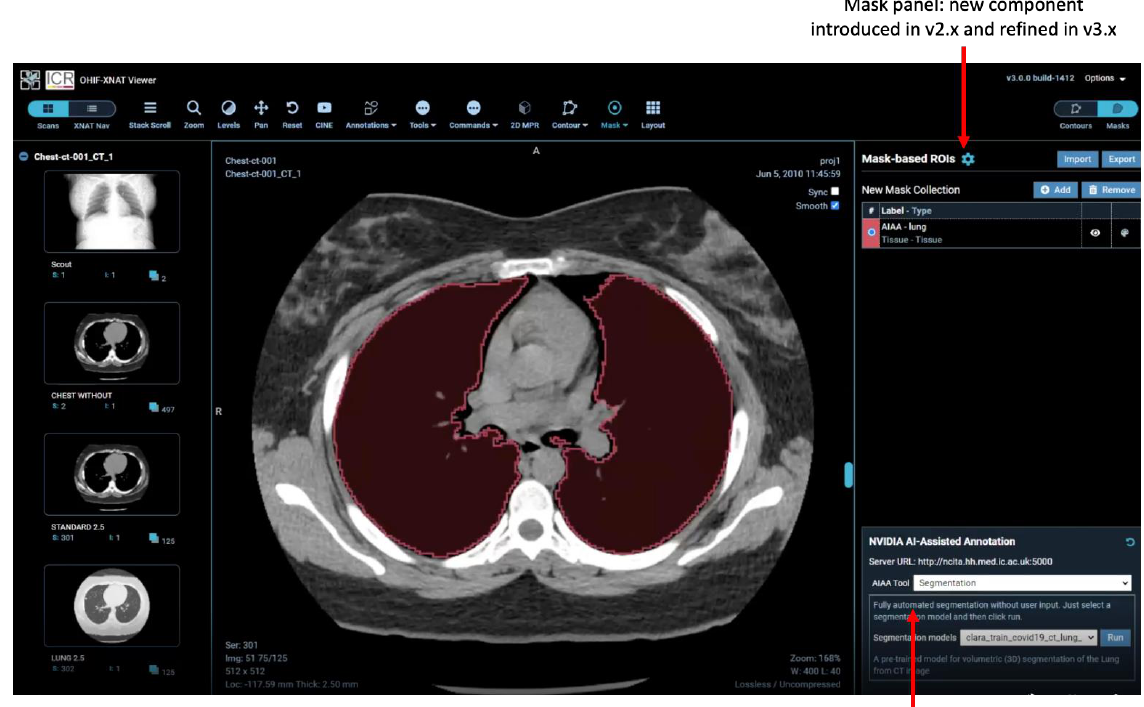
Figure 3. Our integration of the NVIDIA AIAA tool for automatic and semiautomatic segmentation based on machine learning models. A key advantage of the new tool is that the AI-assisted segmentations are processed and stored in exactly the same way as manual segmentations and so any shortcomings in the AI-based results, such as those seen in the left lung here can easily be refined manually and used to retrain the model.